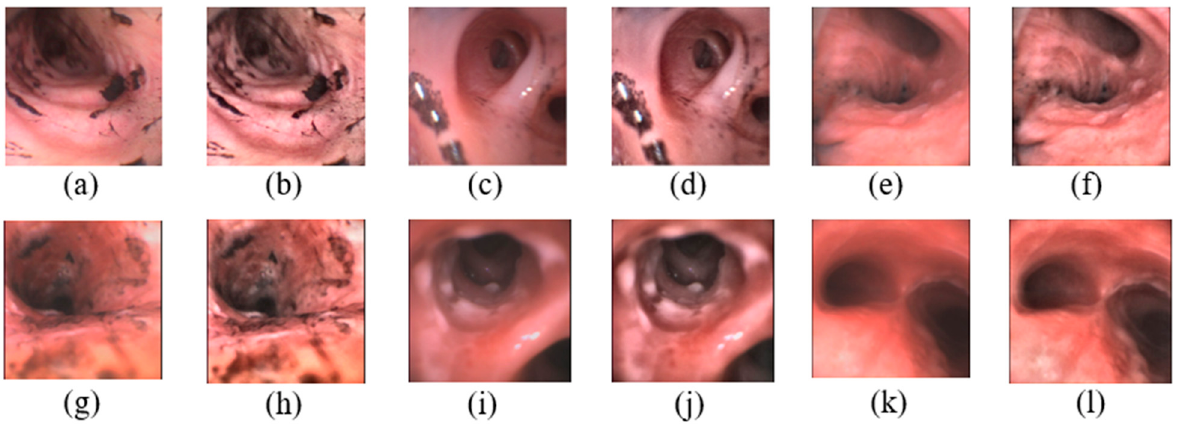
Figure 4. Prepossessed bronchoscopy images from different degrees where ( a , c , e , g , i , k ) are original images from 1st degree to 6th degree; ( b , d , f , h , j , l ) are preprocessed images from 1st degree to 6th degree.